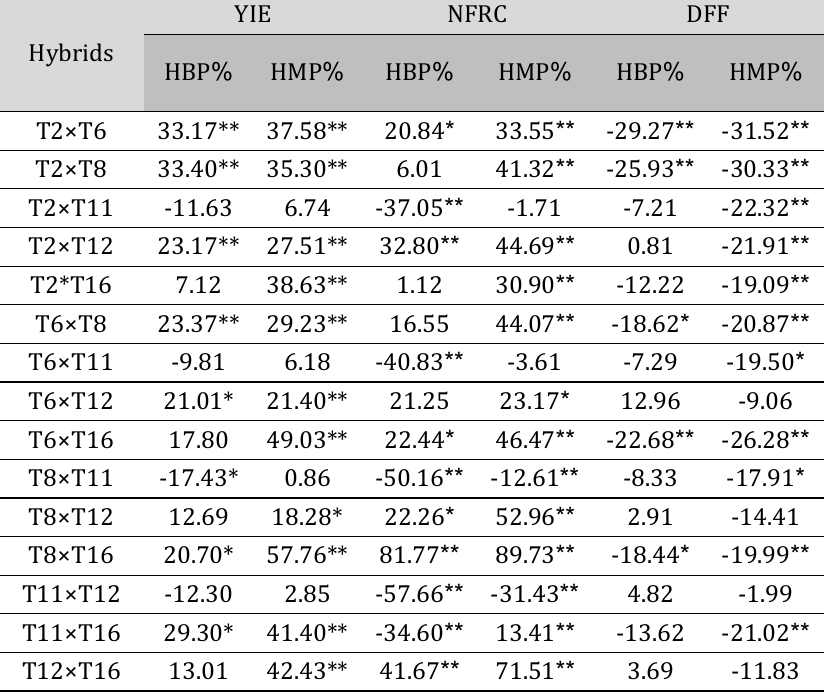
Table 4. Heterosis (%) values compared to the mid-parents (HMP) and the best-parent (HBP) for the traits: single plant yield (YIE), the number of fruits per cluster (NFRC), and days from transplanting to start of flowering